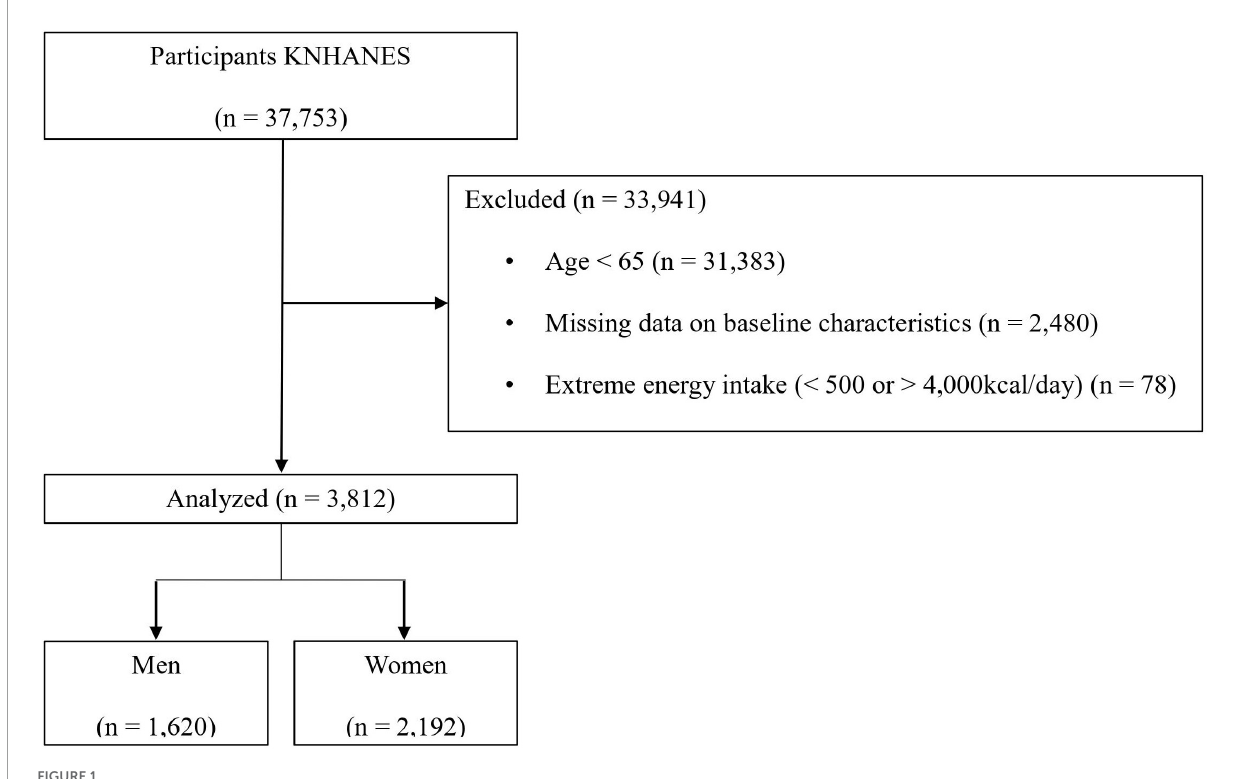
FIGURE1 Flowchart of the inclusion and exclusion of